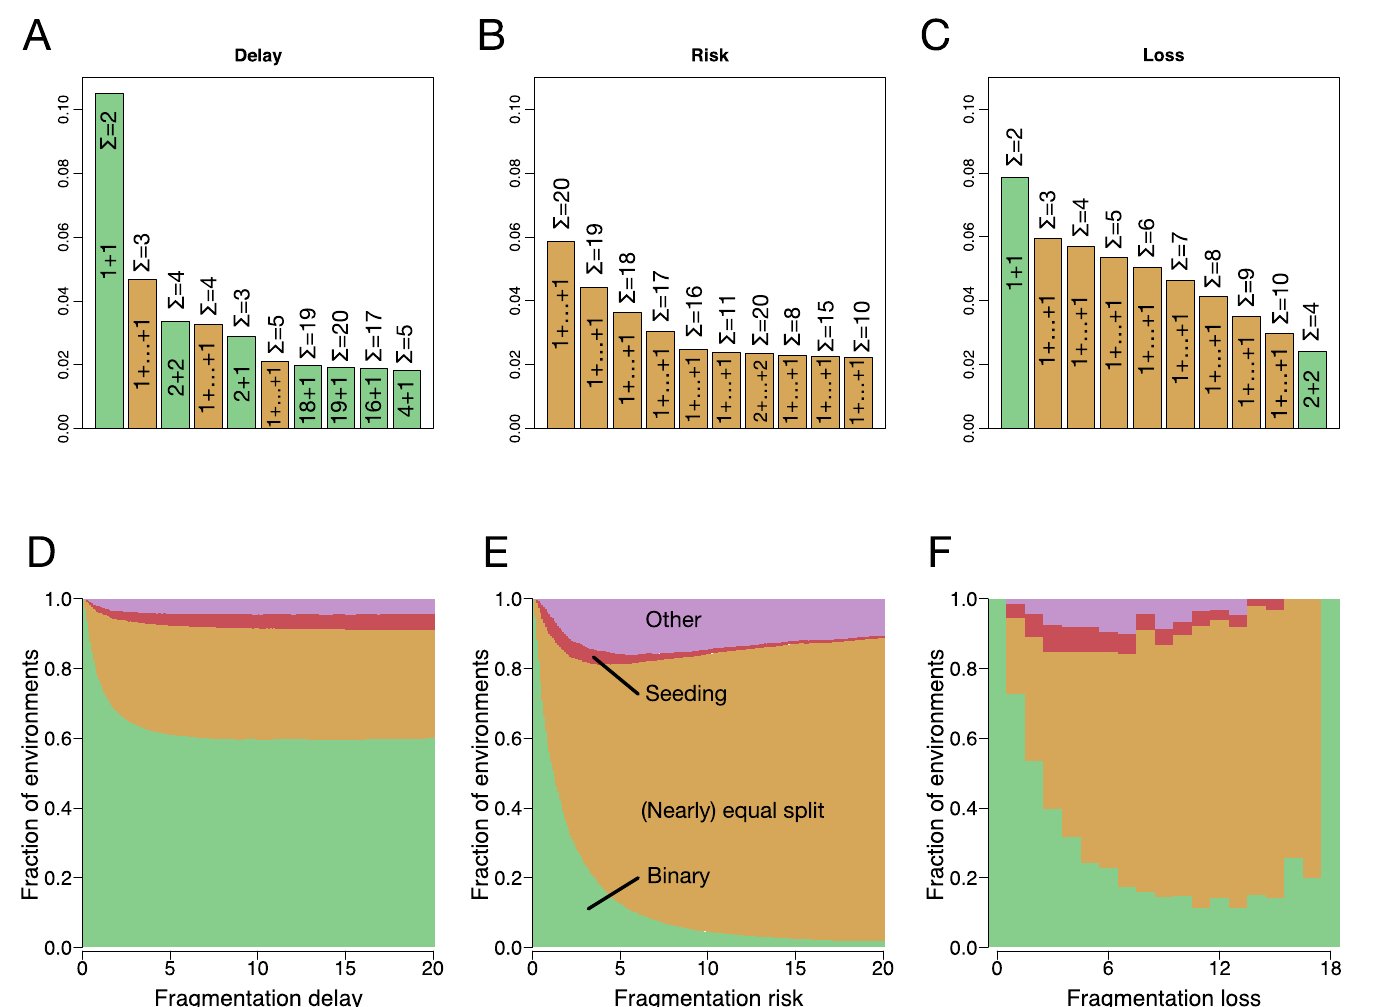
Fig 4. Fragmentations by binary and (nearly) equal split partitions are likely to evolve in random environments. The top panels present the ten most frequent fragmentation modes for ( A ) fragmentation with delay, ( B ) fragmentation with increased death risk and ( C ) fragmentation with cell loss, respectively. Each bar shows the frequency of the corresponding life cycle to be evolutionarily optimal. The colour of the bar represents the class of the life cycle, see Fig 3. (Nearly) equal split life cycles are represented in the form of 1+ ... + 1 and the total number of cells S . The bottom panels (D—F) present the fractions of each of binary fragmentation, (nearly) equal split, seeding, and other allowed fragmentation modes as functions of fragmentation cost for the same scenarios. The majority of random environments promote the evolution of (nearly) equal split and binary fragmentation